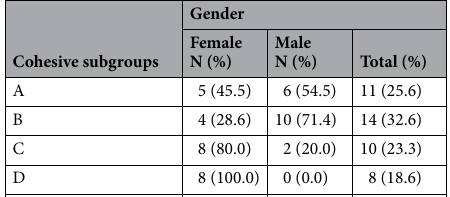
Cohesive subgroups